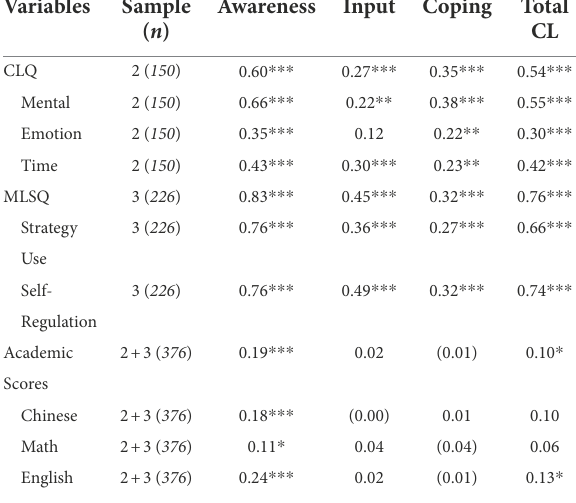
TABLE 5 Partial correlations between SCLS (and its three subscales), CLQ, MLSQ, and academic scores.